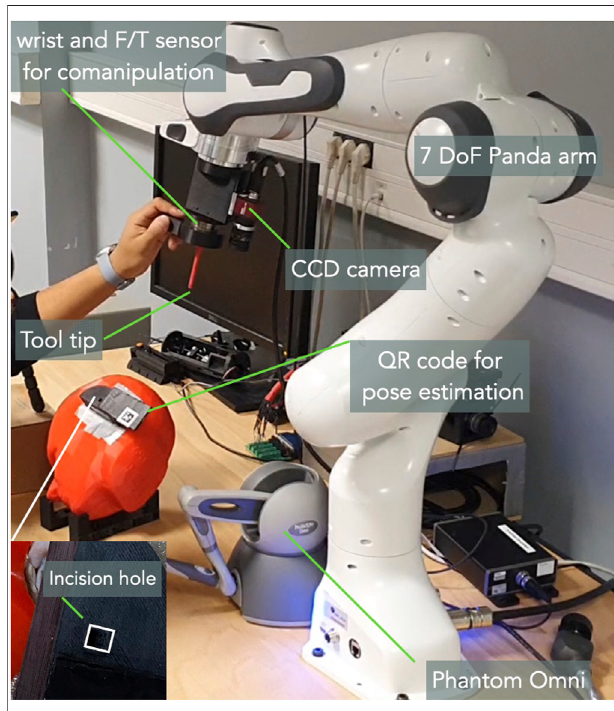
FIGURE 7 | The developed experimental setup for this